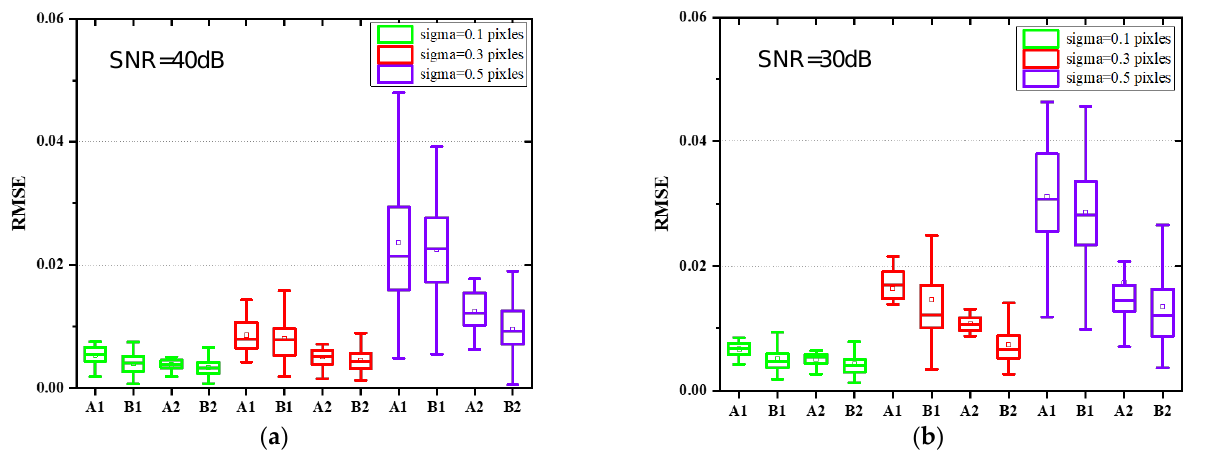
Figure 6. Comparison between the accuracy of two traditional phase retrieval algorithms (A1, B1) and the two jitter-robust phase retrieval algorithms (A2, B2) for a high SNR ( a ) and a low SNR ( b ). We can see that, compared to traditional phase retrieval algorithms, the accuracy of jitter-robust phase retrieval algorithms is insensitive to the presence of